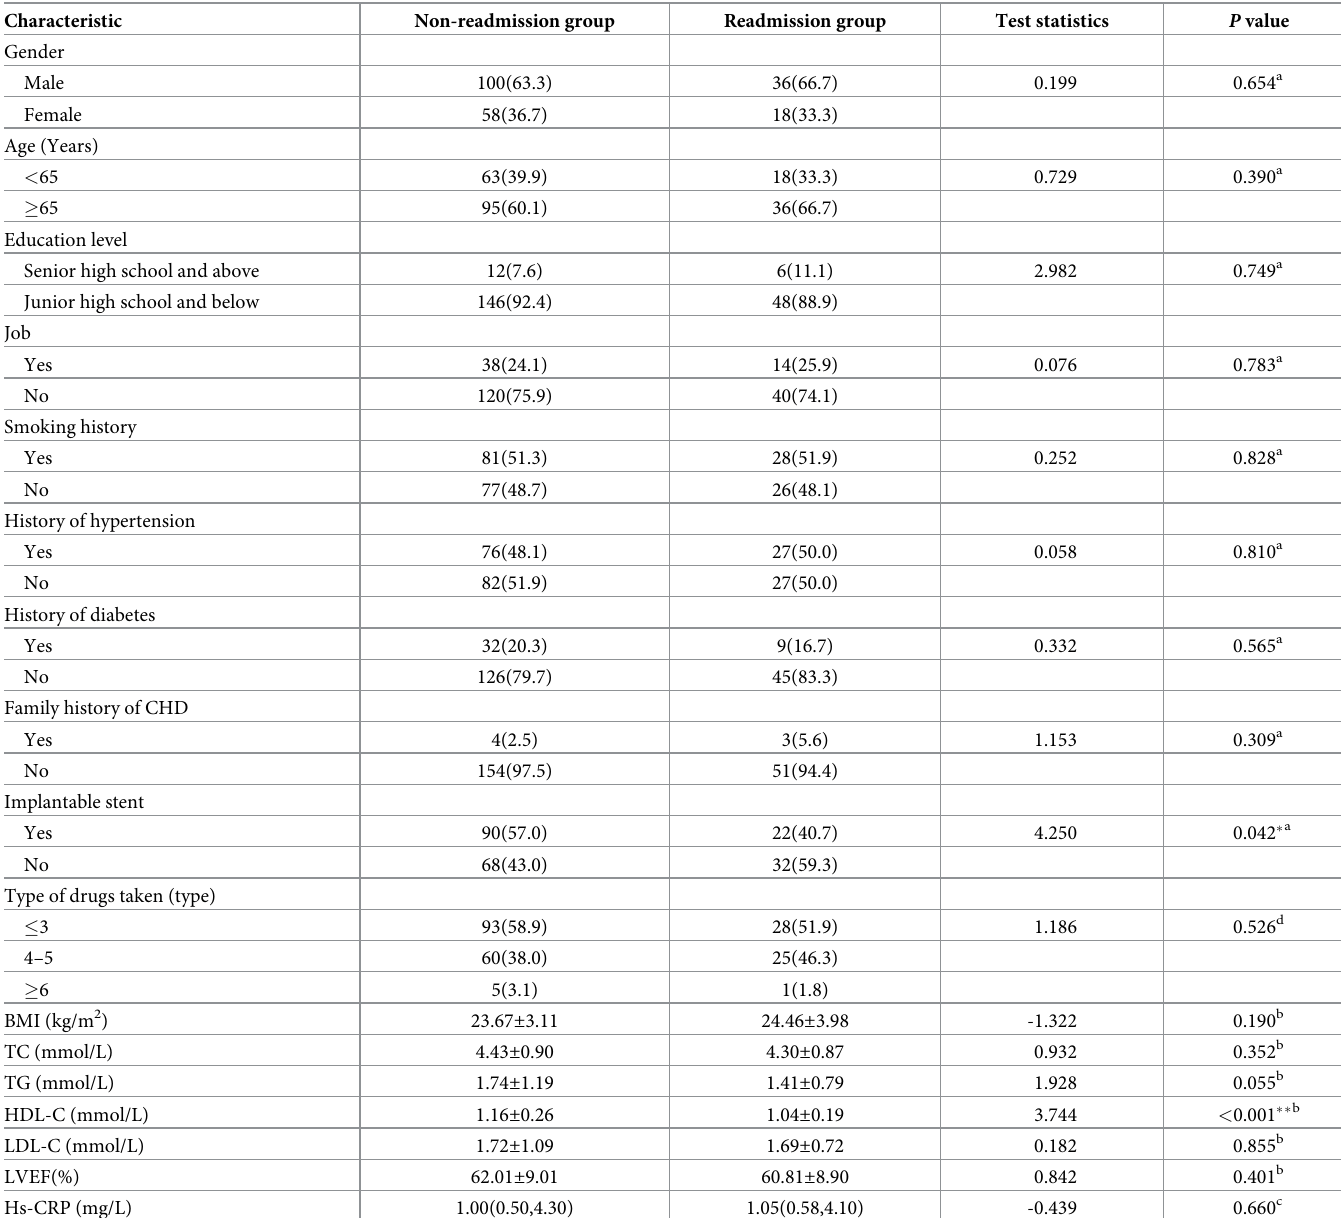
Table 7. Comparison of information on readmitted patients and non-readmitted